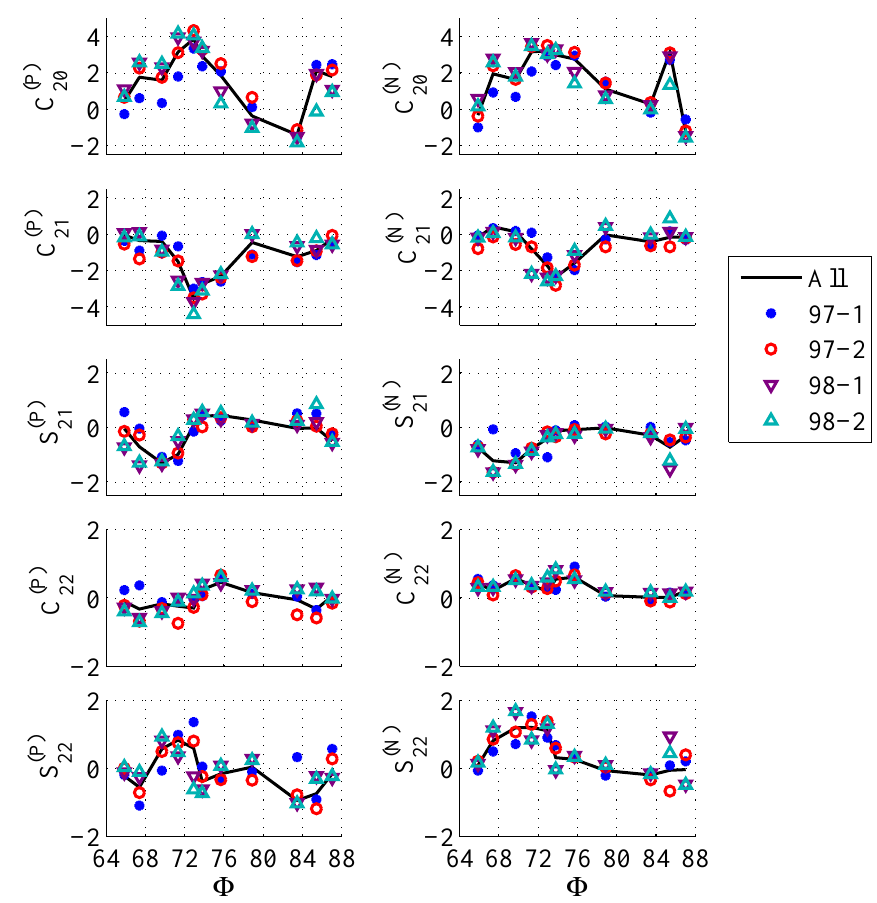
Fig. 8. Coefficients of the Fourier expansion (6) of the parameter Q for the P-component (left) and the N-component (right) in the same format as in Fig.